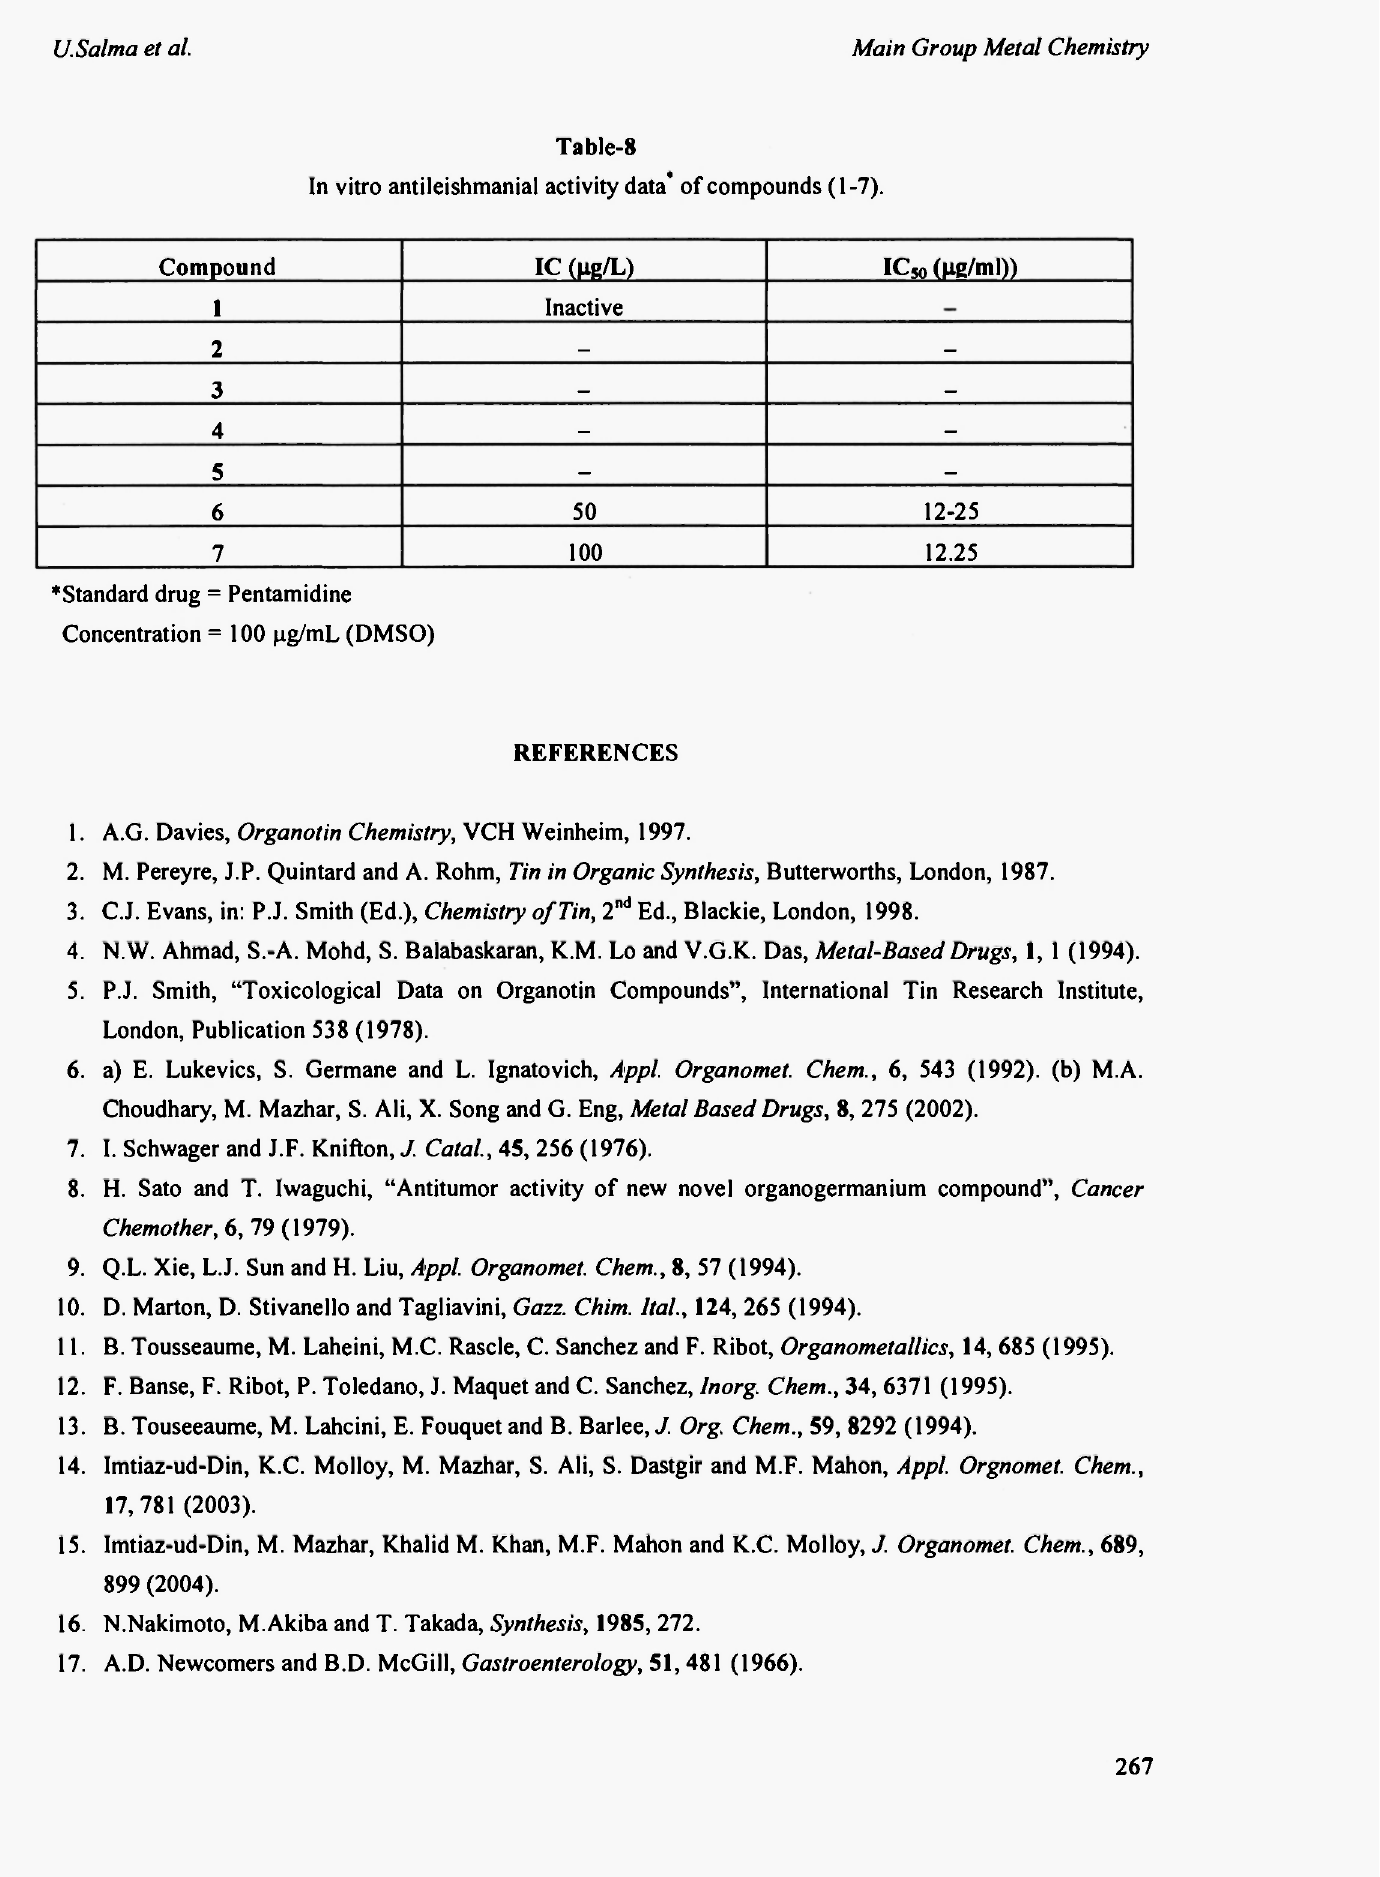
In vitro antileishmanial activity data* of compounds